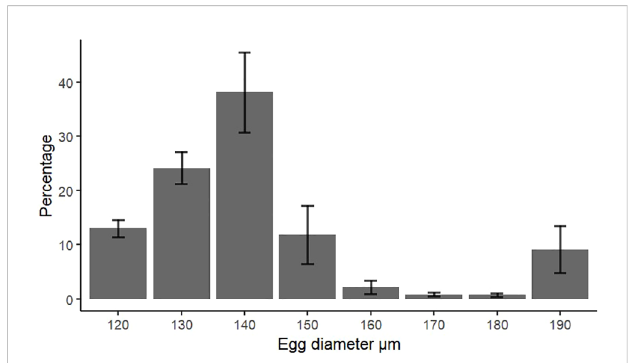
FIGURE 6 Individual fecundity as number of eggs > 120 µm released per individual after heat-shock treatment (n = 73). Circles represent spawning individuals, and asterisks represent non-spawning individuals (34% of individuals included did not spawn).